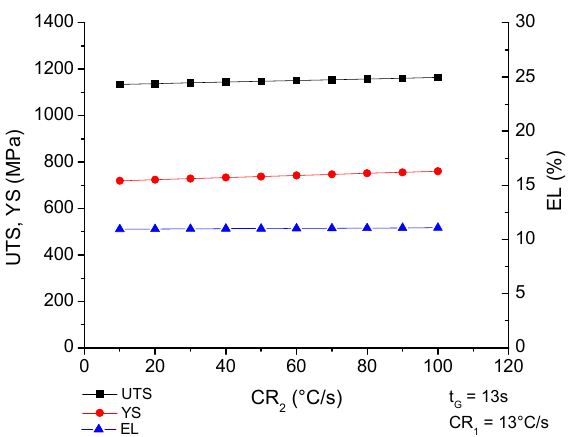
ff ect of CR Figure 9. Effect of CR 2 on UTS mechanical properties in DP steel. Calculations with statistical models. Figure 9. E 2 on UTS mechanical properties in DP steel. Calculations with statistical